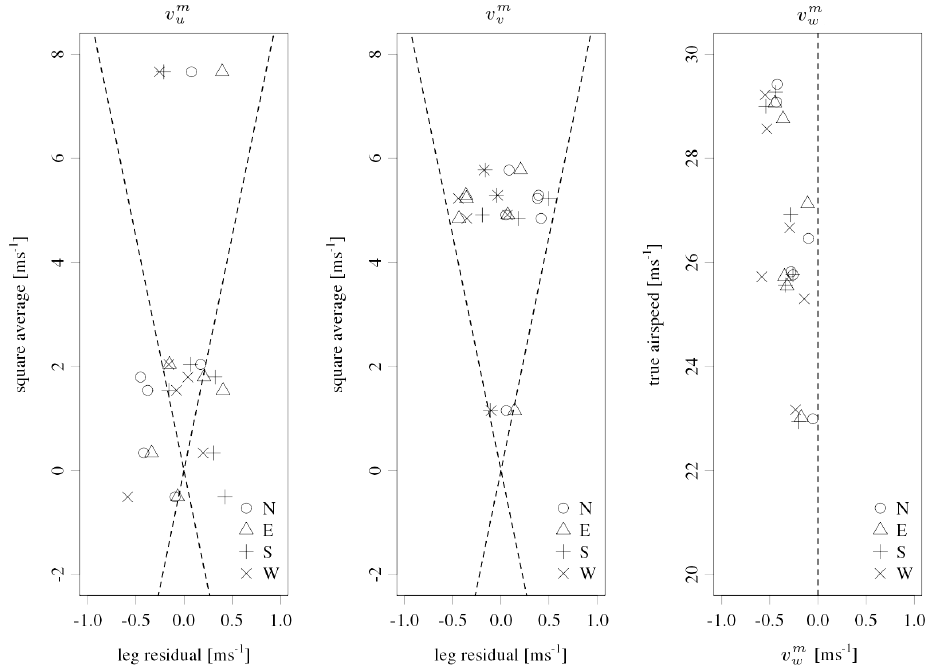
Fig. 11. Results from the wind square flights. For the horizontal wind components ( v m uv ) the x-axis displays the residuals (leg average–square average), while the y-axis shows the wind magnitude. In contrast the vertical wind component ( v m w ) is plotted against the true airspeed. Flight legs are depicted with different symbols according to their position in the square pattern. Dashed lines indicate a 10% criteria for v m uv , and the zero line for v m w .